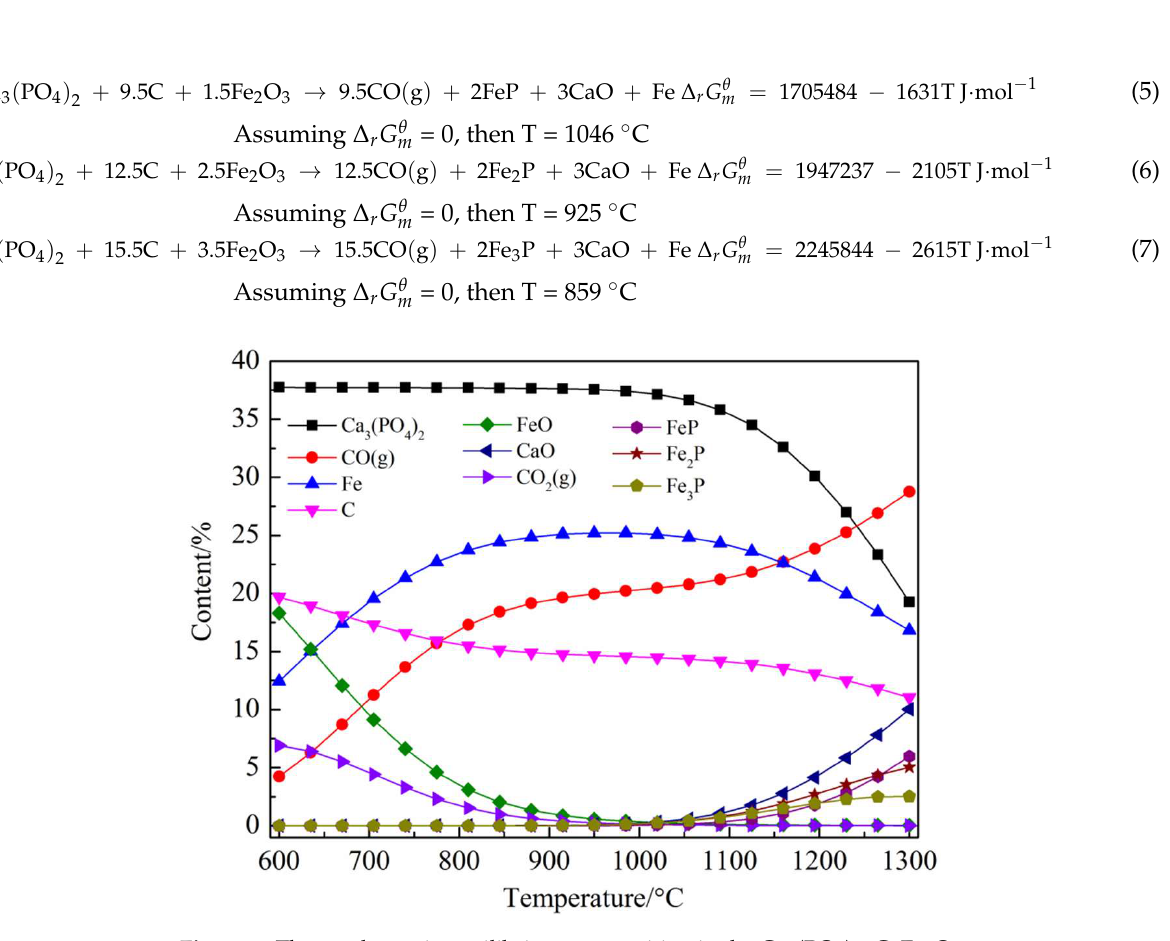
Figure 5. Thermodynamic equilibrium composition in the Ca 3 (PO 4 ) 2 –C–Fe 2 O 3 system.